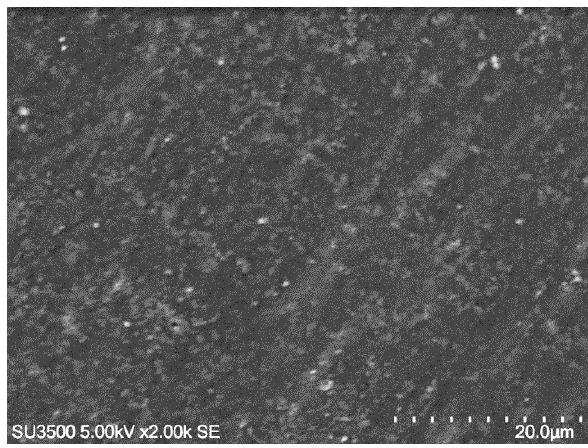
Figure 3. SEM image of epoxy resin showing small air bubbles and patterned lines.